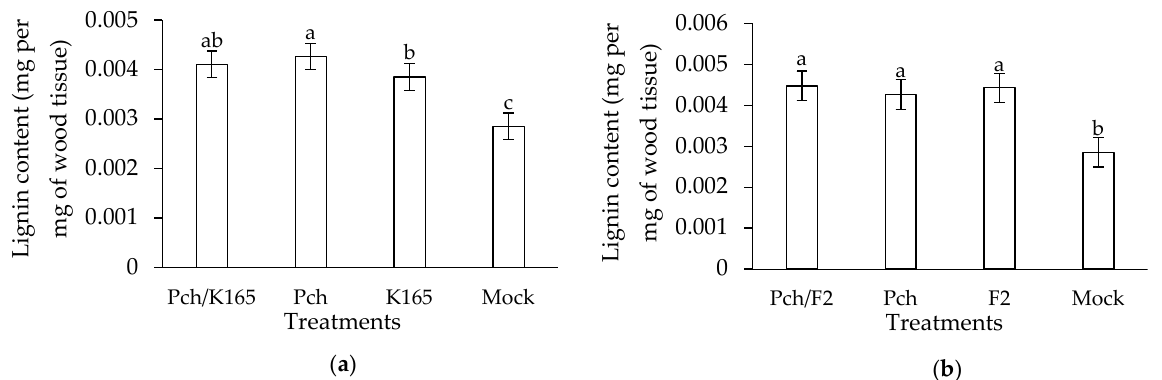
Figure 4. Lignin levels in the Paenibacillus alvei K165 ( a ), Fusarium oxysporum F2 ( b ), and control treated vines inoculated (Pch/K165, Pch/F2, Pch) or not (K165, F2, Mock) with Phaeomoniella chlamydospora (Pch), at 90 days post-inoculation. The columns represent the means of three biological repeats ( n = 3) (with eight grapevines per genotype and repeat). Columns with different letters are significantly different ( p < 0.05) according to LSD test. The vertical bars indicate the standard difference value.